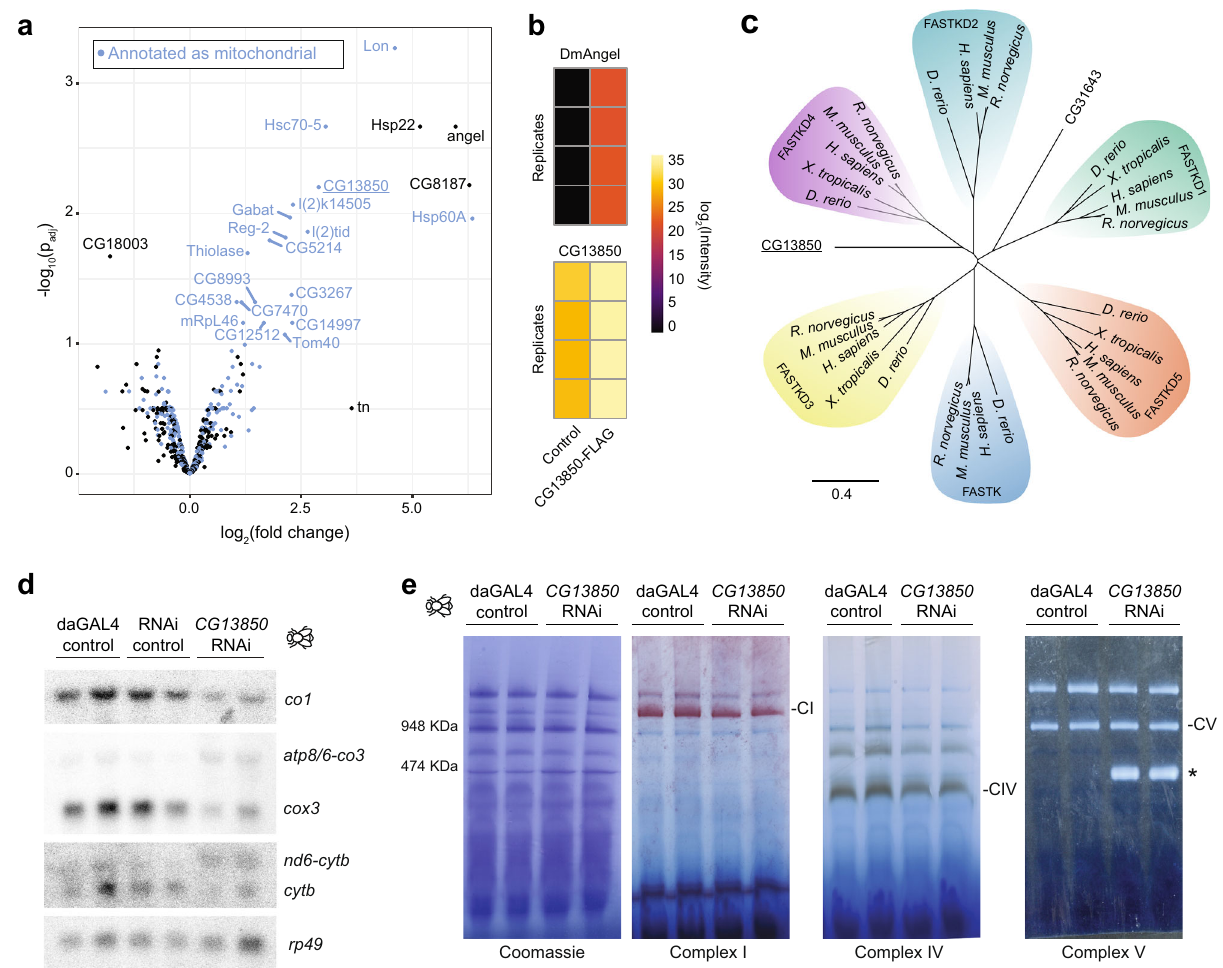
Fig.6|MembersoftheFASTKfamilyarerequiredfornon-canonicalprocessing of mitochondrial transcripts. a Volcano plot of proteomics data from immuno- precipitation (IP) experiments, using 4 dael larvae from Dm ANGEL-FLAG versus Dm ANGEL overexpressing larvae ( n =4). Proteins in the category “ mitochondria ” are highlighted in blue. Limma moderated t -test, p values are given as false dis- covery rate after adjustment for multiple testing ( n =4 biologically independent samples). b Heatmap of the enrichment of Dm ANGEL and CG13850 in CG13850- FLAGIPexperiments( n =4biologicallyindependentsamples). c Neighbour-joining protein MUSCLE alignment of 30 FASTK family members (see Supplementary Table1)from fi vespecies(asindicated)showninanunroutedtreelayout.CG13850